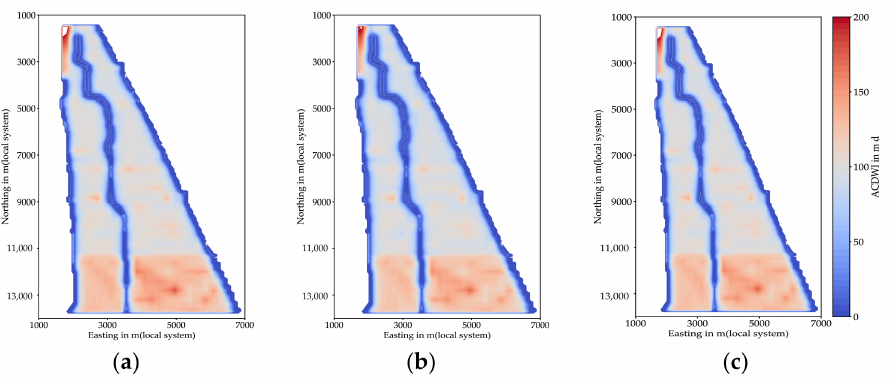
Figure 10. ACDWI for every 10 years of corn growth period during the 1989–2019: ( a ) 1989–1999, ( b ) 2000–2009 and ( c ) 2010–2019.